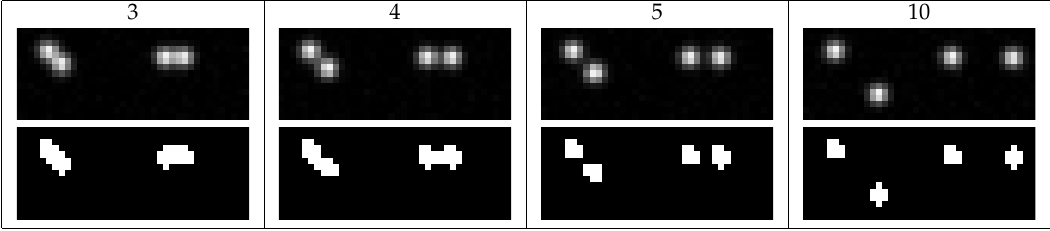
Figure 16. Different particle distances: In the first row, the minimal particle distances are given in pixel. In the second row, example images are given. In the last row, these example images are prefiltered by Otsu’s method as described in